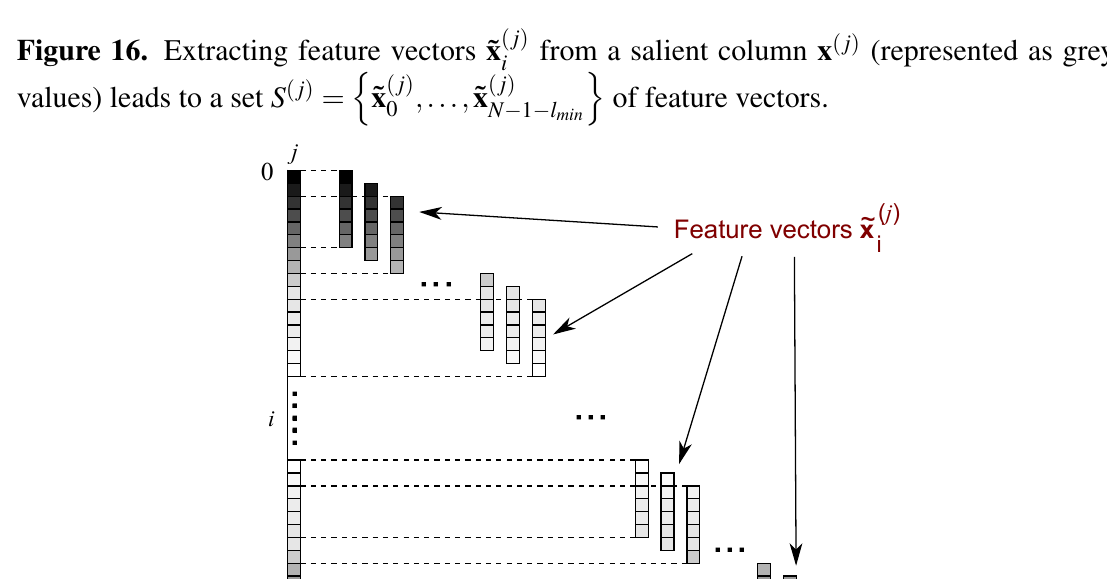
Figure 16. Extracting feature vectors ˜x